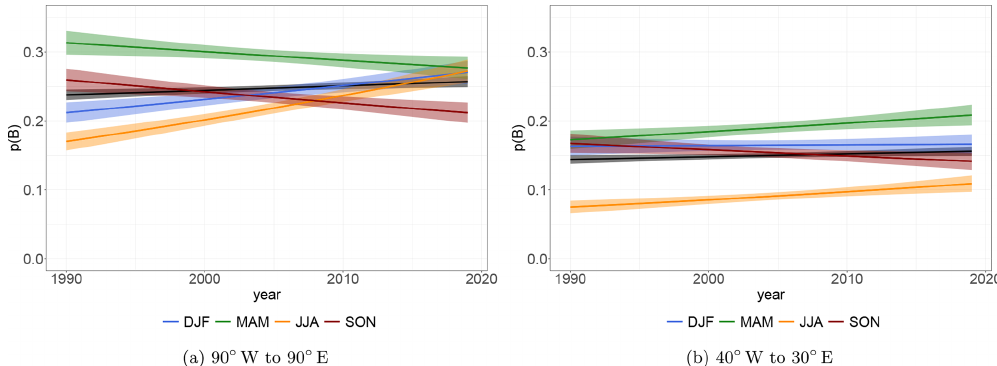
Figure 7. Blocking probability over time for the full year (black line, Eq. 22) and for individual seasons (colored lines; Eq. 24). Shading shows 95% confidence intervals; (a) 90 ◦ W to 90 ◦ E and (b) selected Euro-Atlantic region (40 ◦ W to 30 ◦